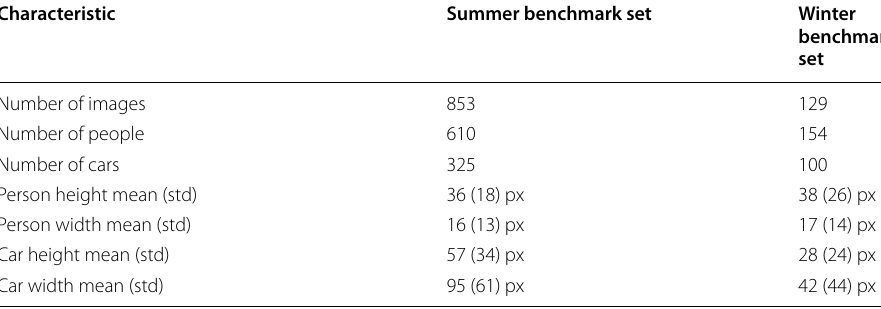
Table 3 Characteristics of the gathered detection benchmark data Characteristic